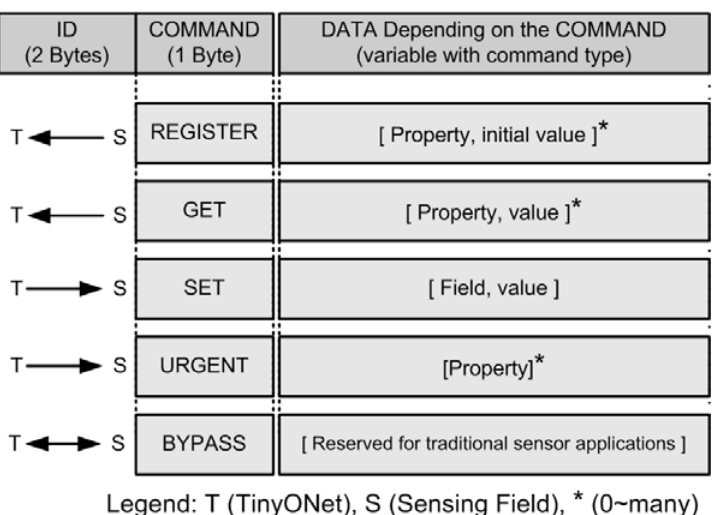
Figure 6. Structure of the data